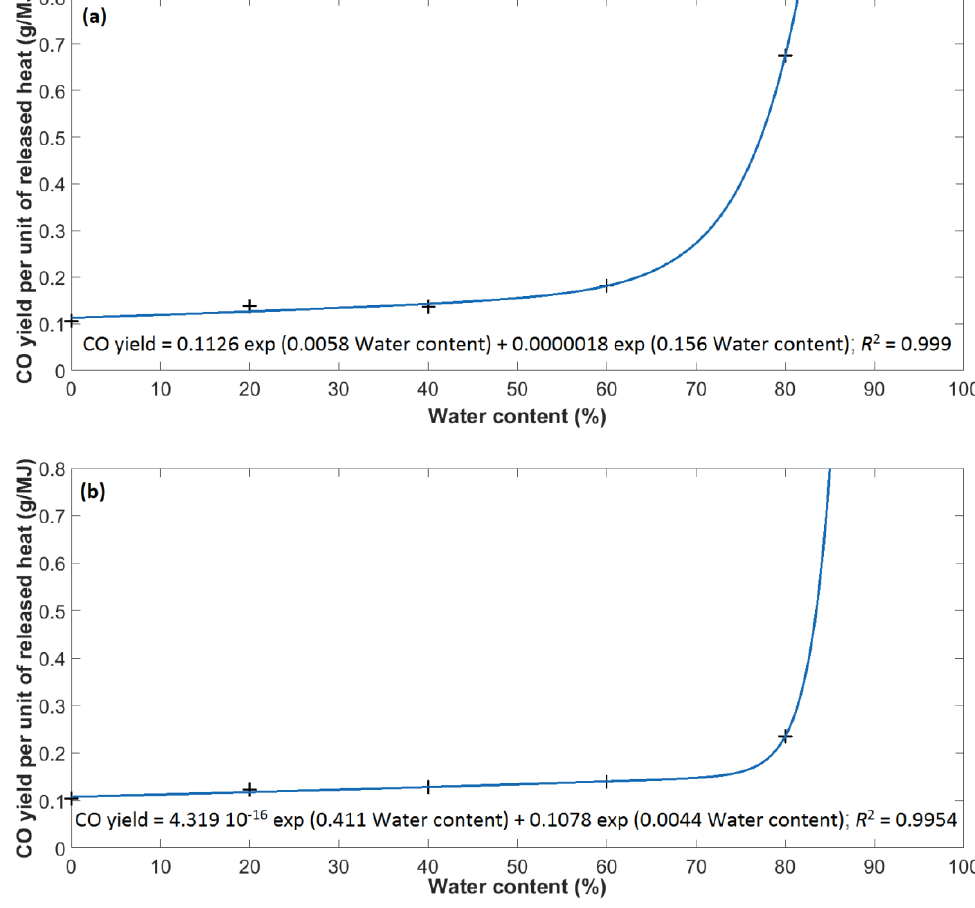
Figure 8. Dependency of the CO yields (per released heat) of investigated fuels on the water content: ( a ) Dependency of the CO yields (per released heat) of methanol on the water content; ( b ) Dependency of the CO yields (per released heat) of ethanol on the water content.